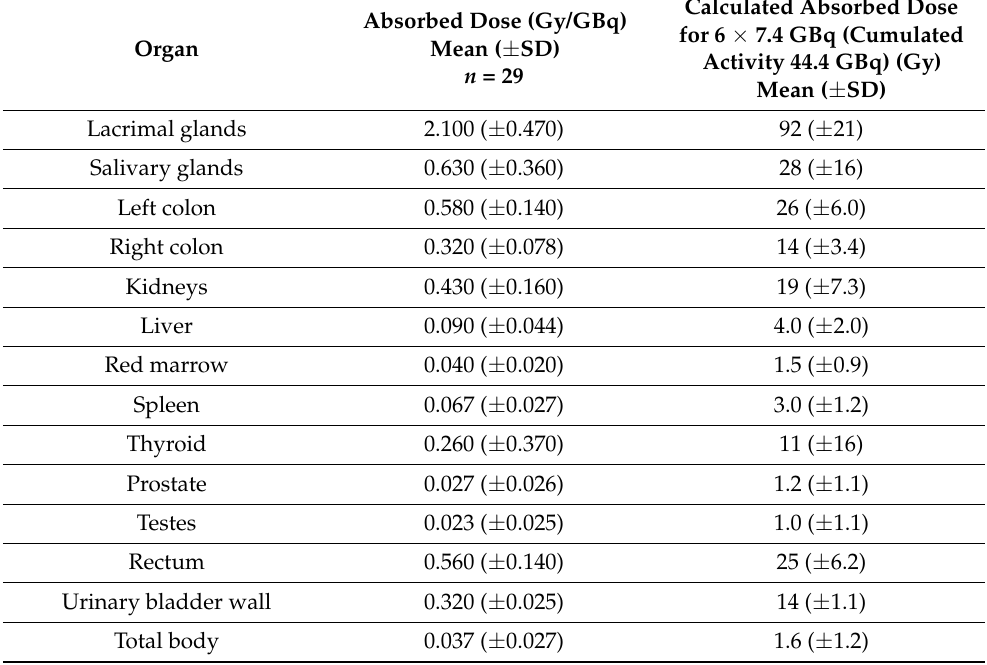
Table 1. Absorbed organ doses of [ 177 Lu]Lu-PSMA-617 in selected organs